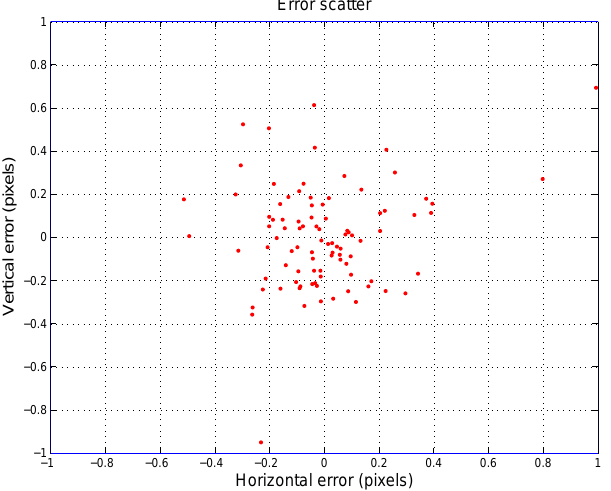
Fig. A7. Same as Fig. A3, but for the ST-9 imager located at the HIPAS